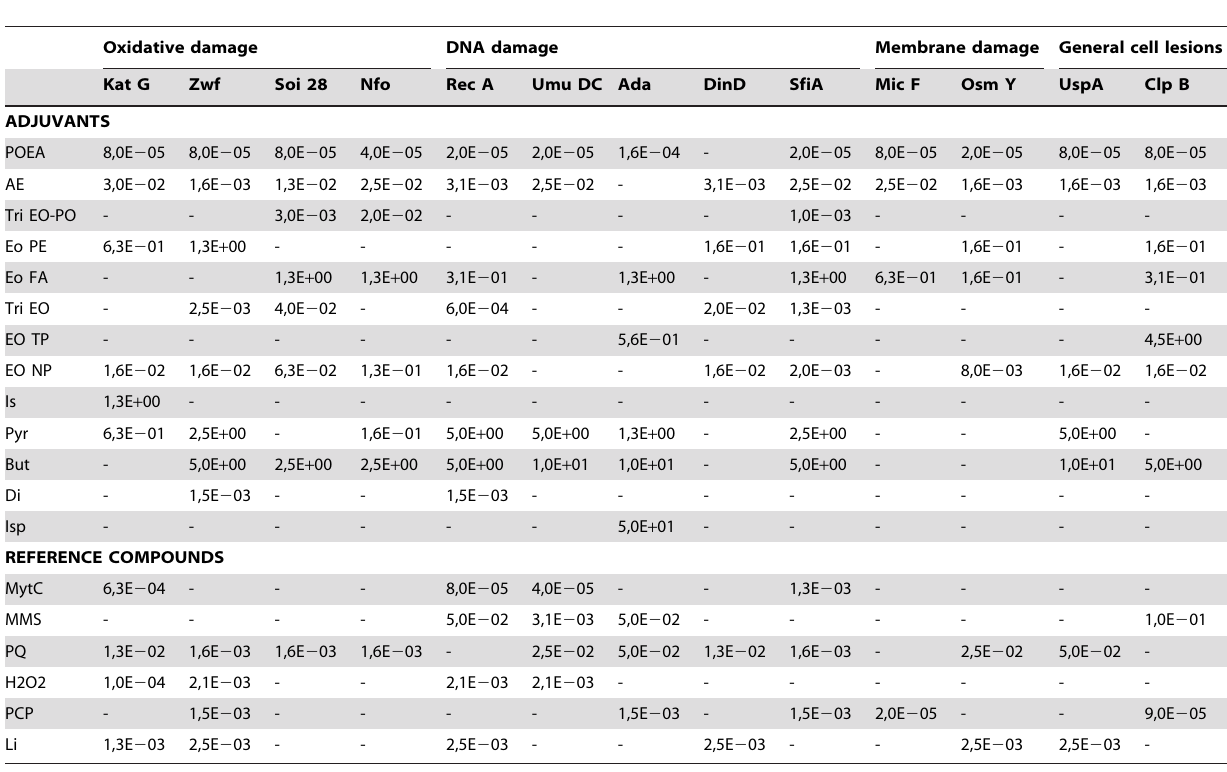
Table 4. Statistically derived no observed effect concentrations (NOEC) (g/L) at the level of gene expression for significantly induced genes (ANOVA, post hoc Dunett’s test p , 0.05).